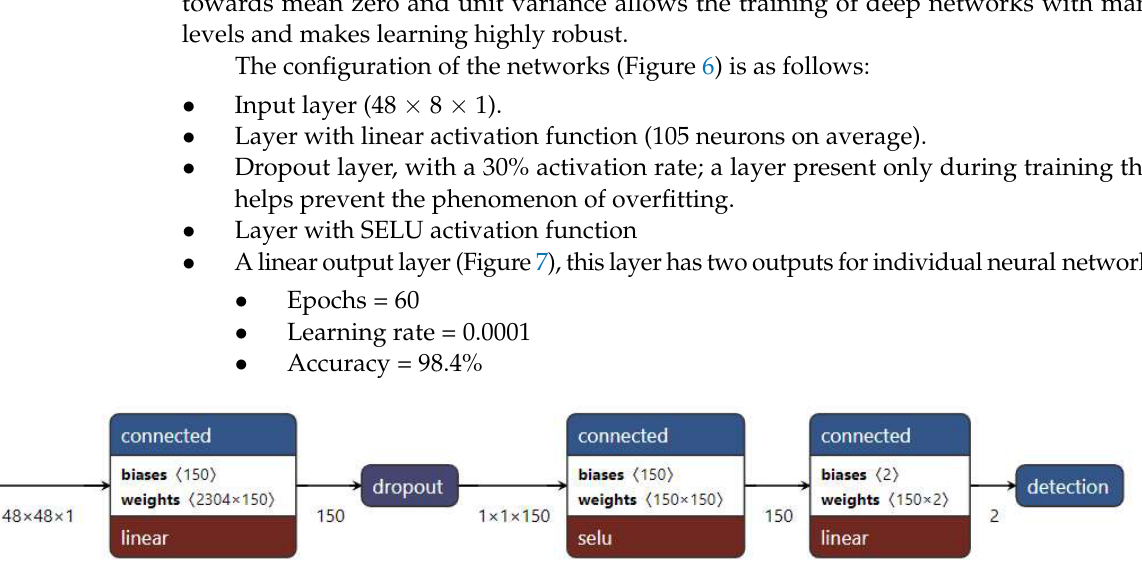
Figure 6. Network Figure 6. Network configuration. Figure 6. Network configuration.